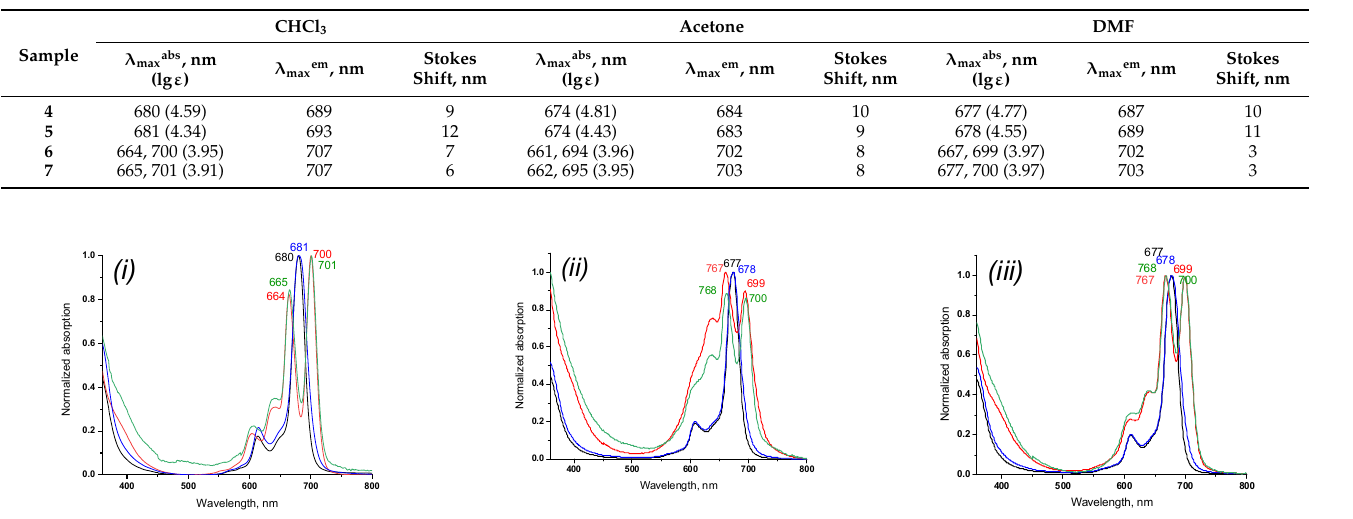
Table 1. Spectroscopic characteristics of phthalocyanines 4 – 7 in different solvents.